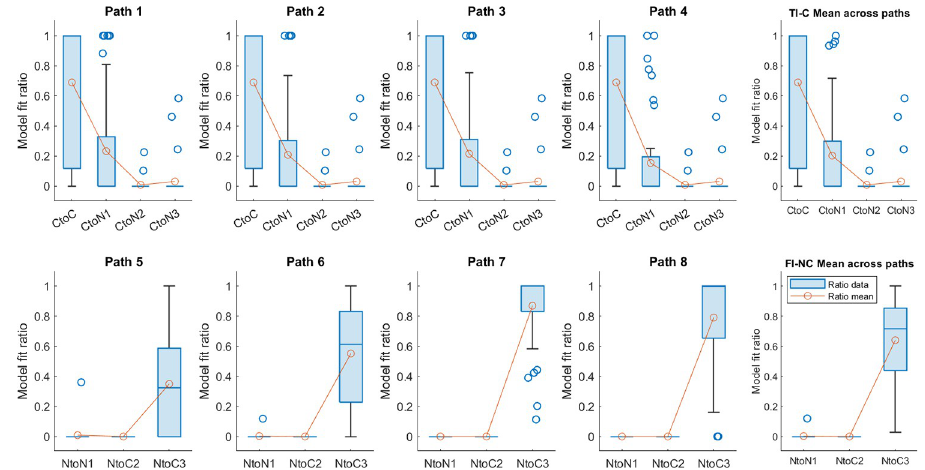
Fig 12. Distribution of model fit ratios for individual participants in Experiment 3. Orange circles show the mean ratios of each hypothesis. Box boundaries show interquartile ranges. Lines inside box show medians. Lower and upper error lines show nonoutlier minimum and maximum values,